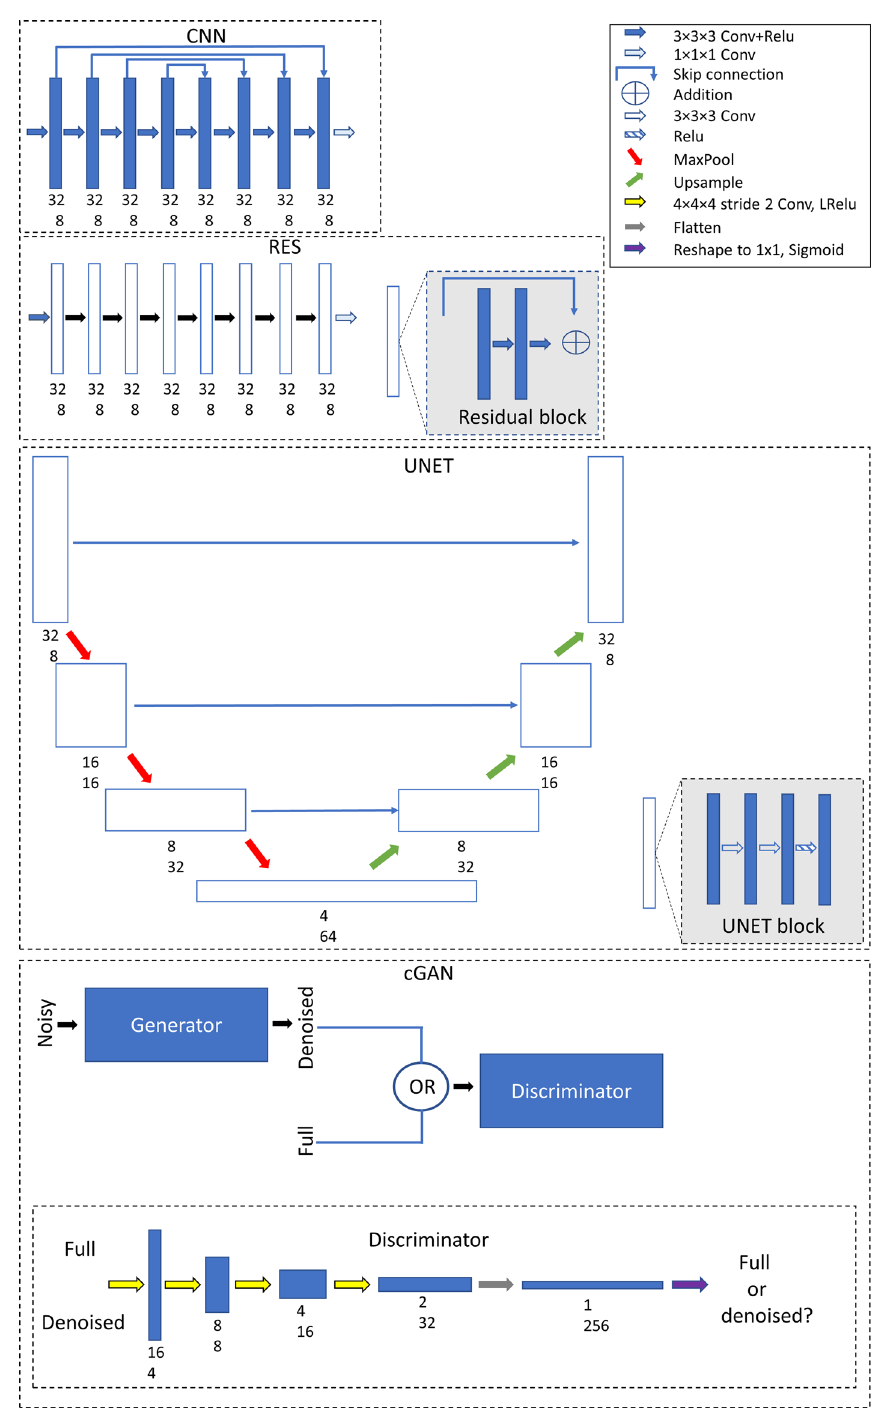
Fig. 1 DL models. The number under the blocks presents the patch size (upper number) and number of filters (lower number). Noisy 32 32 32 patches cropped from reduced acquisition time OSEM images were × × used as model input and model gave denoised 32 32 32 patches as output. Output patches were later × × combined using weighted averaging to produce images at the original reconstruction matrix